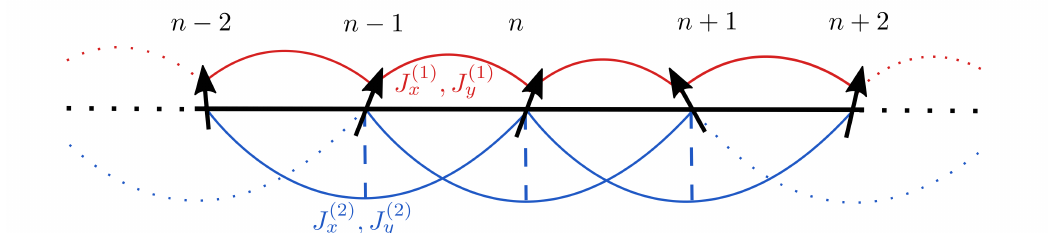
, J ( 1 ) (red x y and J ( 2 ) x y